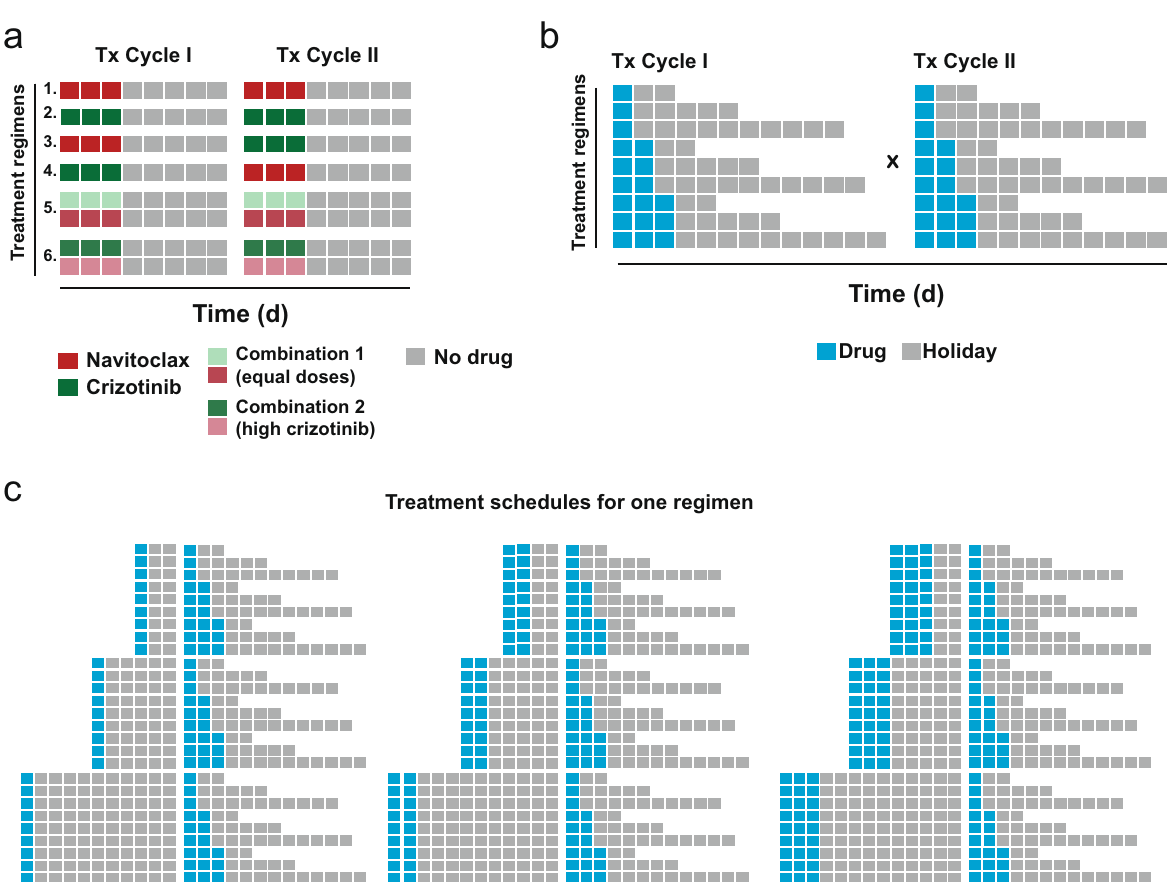
Fig. 1 Schematic of in-vitro experimental design to assess the ef fi cacy of drug combinations. a Depiction of the six sequential and concurrent treatment regimens tested in this study. A seventh regimen included vehicle treatment. b Treatment regimens included two treatment cycles, each comprising of a treatment phase (incubation with the drug) and a drug-free recovery period. c Set of 81 treatment schedules evaluated for each treatment